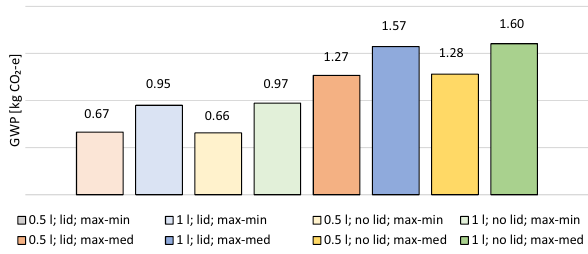
Fig. 6 Comparative environmental impact of the preparation of 0.1 kg of pasta in the impact category GWP (cooking phase only). A distinction is made between the three factors water quantity (0.5 l or 1 l), lid (lid or no lid) and power setting (max–min or max-med). The baseline scenario is represented by the factor level combina- tion "1 l; no lid;